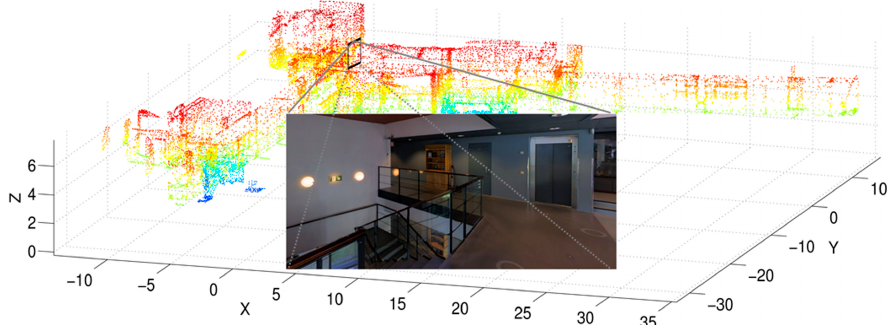
Figure 5. Experimental environment of the positioning and motion state estimation of this study, which is represented by the 3D point cloud and a snapshot of the interior structure of the FGI